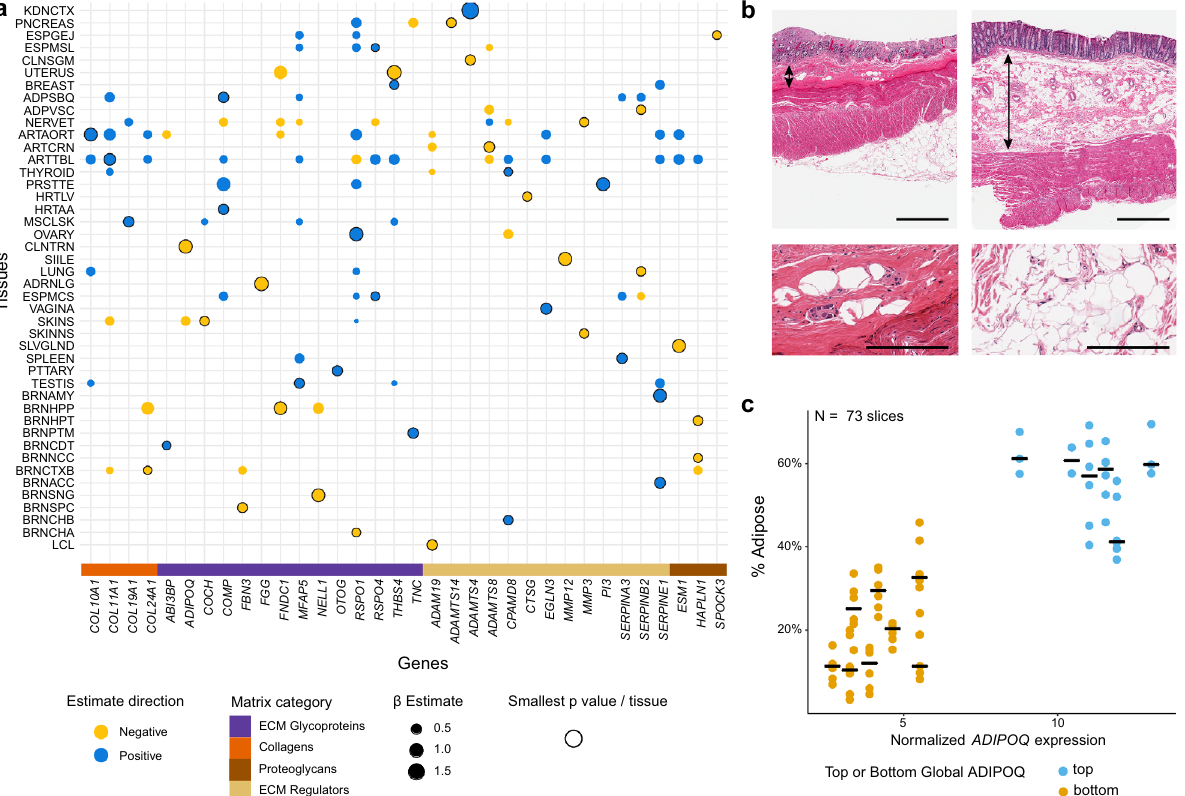
Figure 2. Age-associated transcriptomic changes of the matrisome. ( a ) A plot indicating the 32 transcripts with the largest change in expression relative to age. The transcript with the smallest FDR-adjusted p-value per tissue is noted along with all other instances of that transcripts having a β estimate ≥ 0.15 in other tissues. Tissues with no significant findings (FDR-adjusted p > 0.05) were not included. ( b ) Representative images of the transverse colon with varying levels of multi-tissue ADIPOQ expression at two different powers. The left sample, GTEX- 14C5O, had low levels of ADIPOQ and is notable for a thin submucosa (two-headed arrow) with few adipocytes. The right sample, GTEX-1KXAM, had high levels of ADIPOQ , with a notable submucosal area containing large numbers of adipocytes. The bars are 1 mm and 200 µm for the low and high power views respectively. ( c ) A scatterplot representing the percent of adipose tissue in the submucosa of the transverse colon for the top 6 and bottom 8 individuals ordered on body wide ADIPOQ expression. The datapoints (n = 2 to 6, median of 6, per individual) of multiple measured areas per sample are colored to represent the top (blue) or bottom (yellow) multi-tissue ADIPOQ expressors. Bars indicate the median level of submucosal adipocytes for each